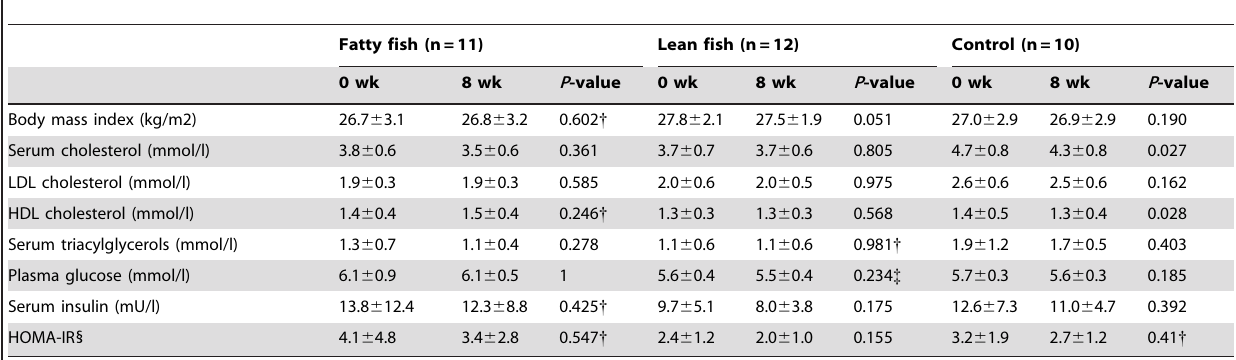
Table 1. Clinical characteristics at baseline and after the 8-week intervention (mean 6 SD).